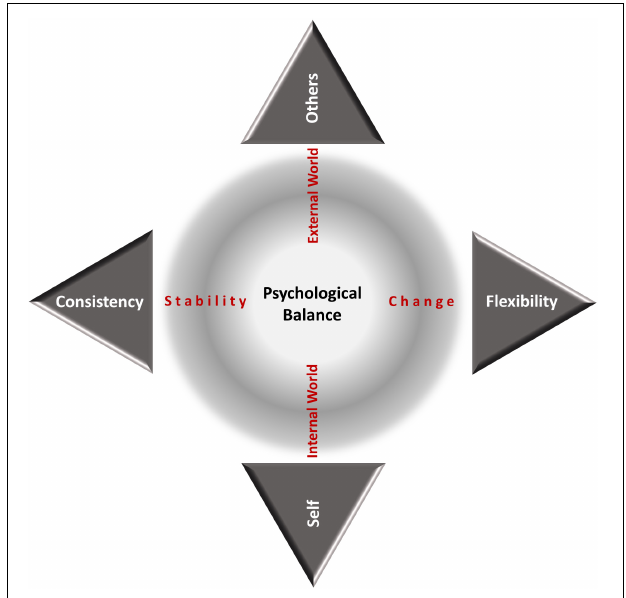
FIGURE 2 | Psychological Balance moves on a horizontal axis between Consistency and Flexibility and on a vertical axis between Self and